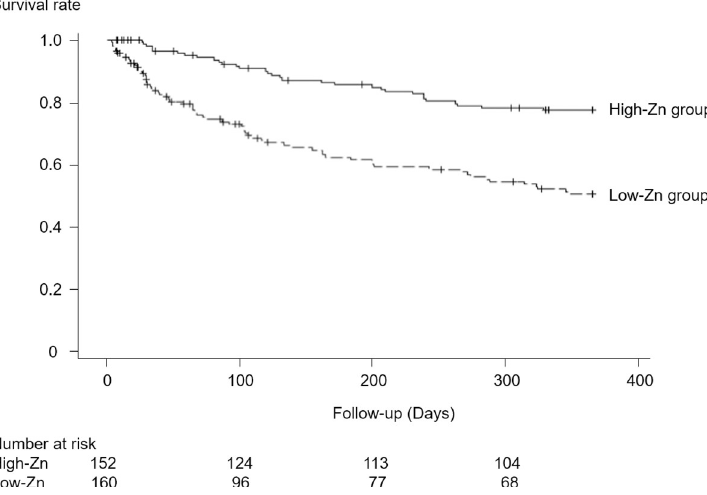
Fig 2. Survival rates in the original study population. Kaplan-Meier curves for the primary outcome over 1 year.